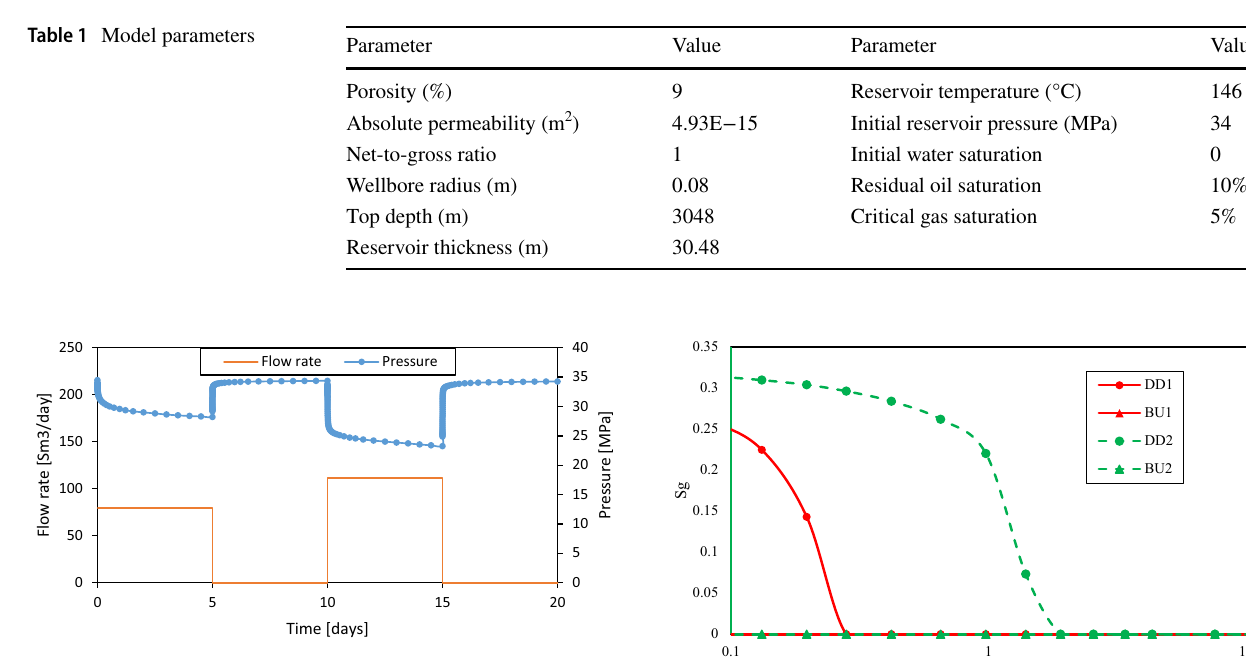
Fig. 3 Pressure and rate histories (case 1)